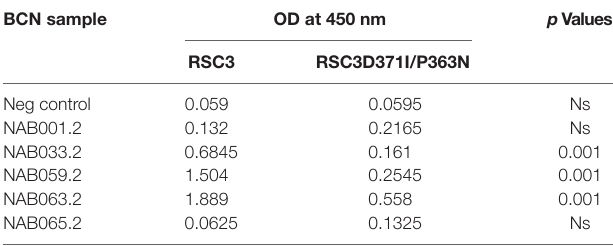
TaBle 4 | ELISA with RSC3 and RSC3 Δ 371I/P363N